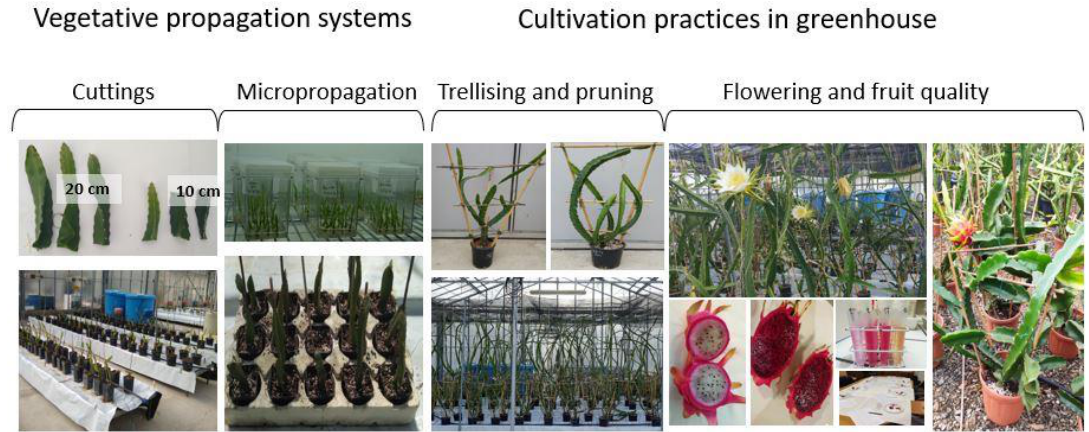
Figure 1. Overview of the whole chain approach, from propagation to the greenhouse cultivation of species belonging to the genus Hylocerius spp.